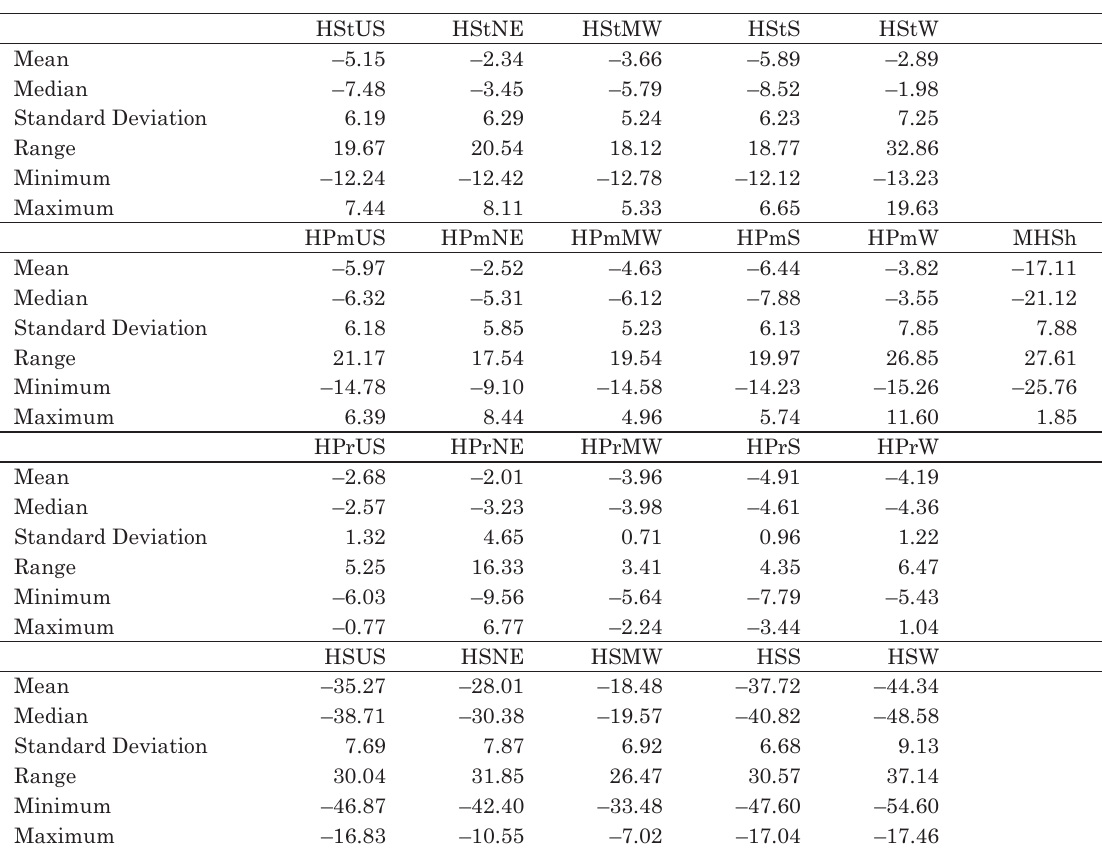
table 2. Summary statistics on impuse response